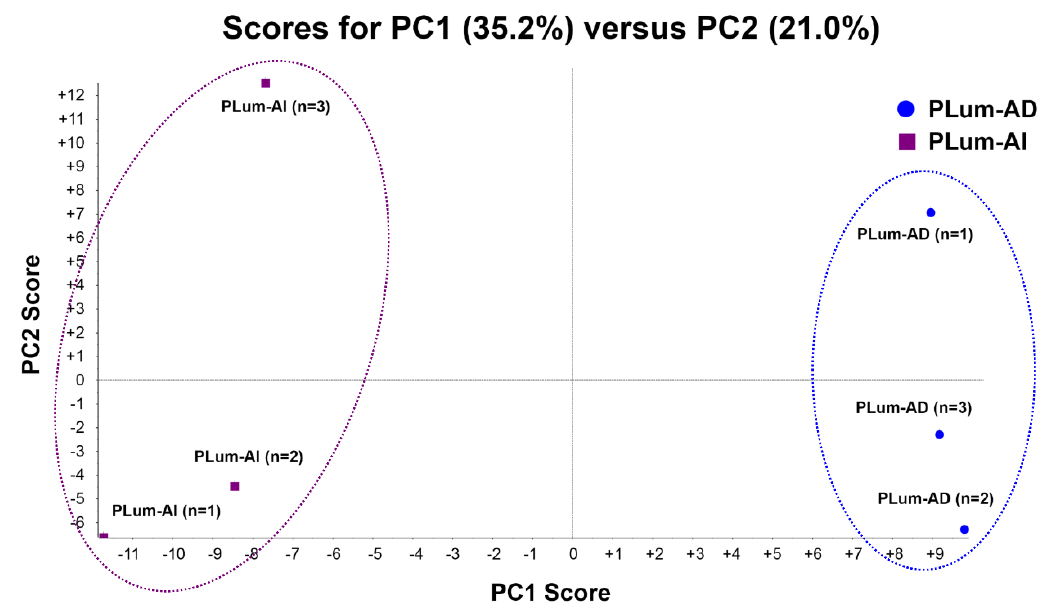
Figure 2. Principle component analysis (PCA) of protein profiles. PCA projection of protein profiles of PLum-AI and PLum-AD cells obtained from three independent biological samples for each cell line.